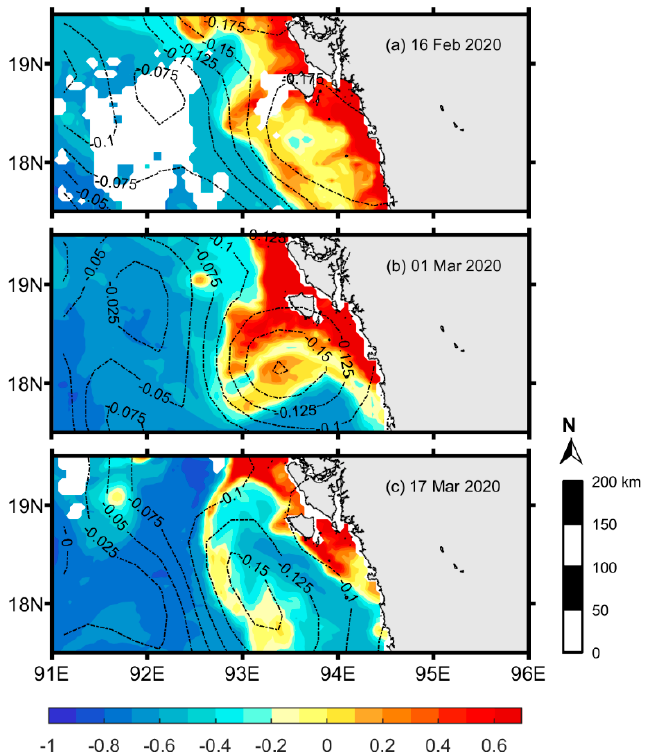
Figure 8. Logarithm (Log 10 ) of Chl- a concentrations (shaded, unit: mg m − 3 ) and SLA (contours, unit: m) in the waters of Manaung Island for ( a ) 16 February, ( b ) 1 March, and ( c ) 17 March in 2020. Blank areas indicate missing data.